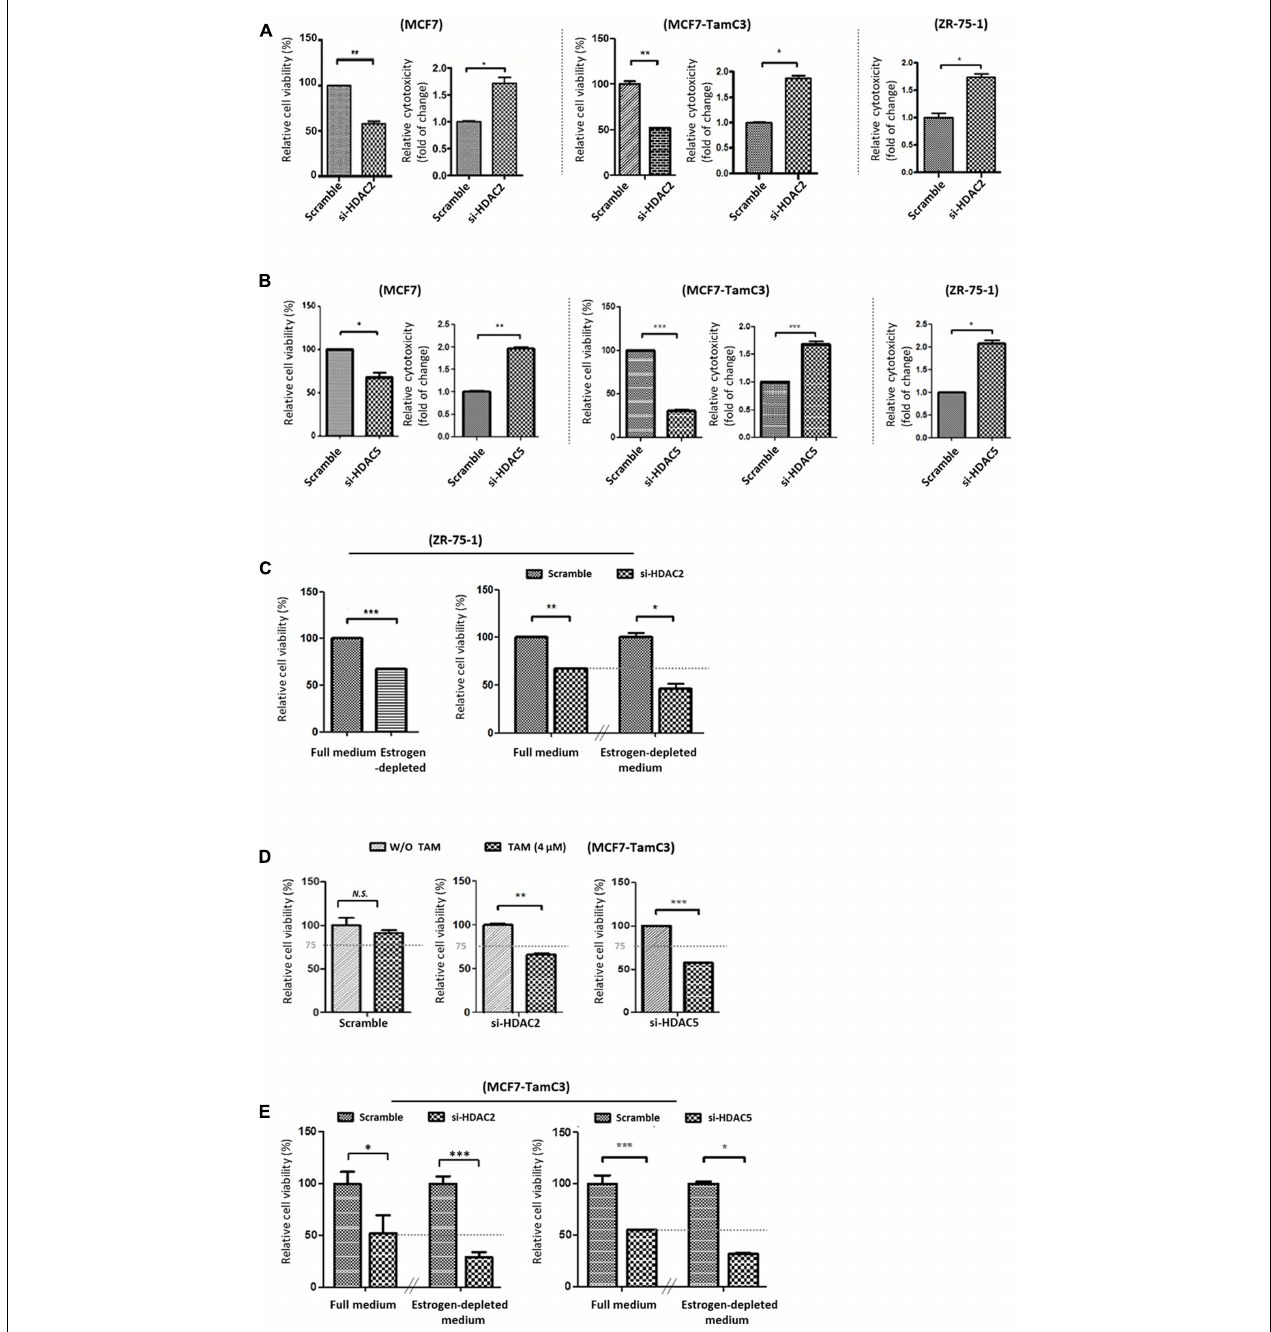
FIGURE 2 | Downregulation of HDAC2 and HDAC5 increases the sensitivity to tamoxifen and restores the sensitivity to estrogen deprivation in MCF7-TamC3 cells. (A,B) MCF7, MCF7-TamC3, and ZR-75-1 cells were transfected with scramble siRNA, HDAC2 siRNA, or HDAC5 siRNA. Cell viability and cytotoxicity was assessed by the MTT assay (96 h post-treatment) and LDH assay (5 days post-treatment), respectively. (C) Left panel: ZR-75-1 cells were cultured under either estrogen-containing (full medium) or estrogen-deprived conditions for 96 h. Cell viability was assessed by the MTT assay. Right panel: ZR-75-1 cells were pre-transfected with either scramble siRNA or HDAC2 siRNA for 24 h and subsequently cultured under either estrogen-containing or estrogen-deprived conditions for 96 h. Cell viability was assessed by the MTT assay. (D) MCF7-TamC3 cells were pre-transfected with scramble siRNA, HDAC2 siRNA, or HDAC5 siRNA for 24 h and co-treated with or without tamoxifen for 72 h. Cell viability was assessed by the MTT assay. (E) MCF7-TamC3 cells were pre-transfected with scramble siRNA, HDAC2 siRNA, or HDAC5 siRNA for 24 h and subsequently cultured under either estrogen-containing or estrogen-deprived conditions for 72 h. Cell viability was assessed by the MTT assay. “ ∗ ” , “ ∗∗ ” , and “ ∗∗∗ ” denote a statistical significance ( P < 0.05, P < 0.01, and P < 0.001, respectively) between the testing groups. “ N.S. ” denotes no statistical significance between the testing groups.